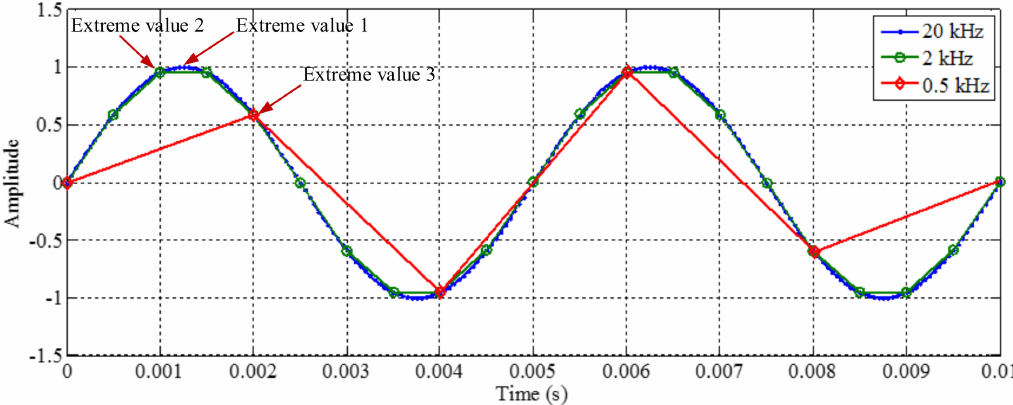
Figure 4. The distributions of extreme values of a signal of 200 Hz with sampling frequencies of 0.5, 2 and 20 kHz.